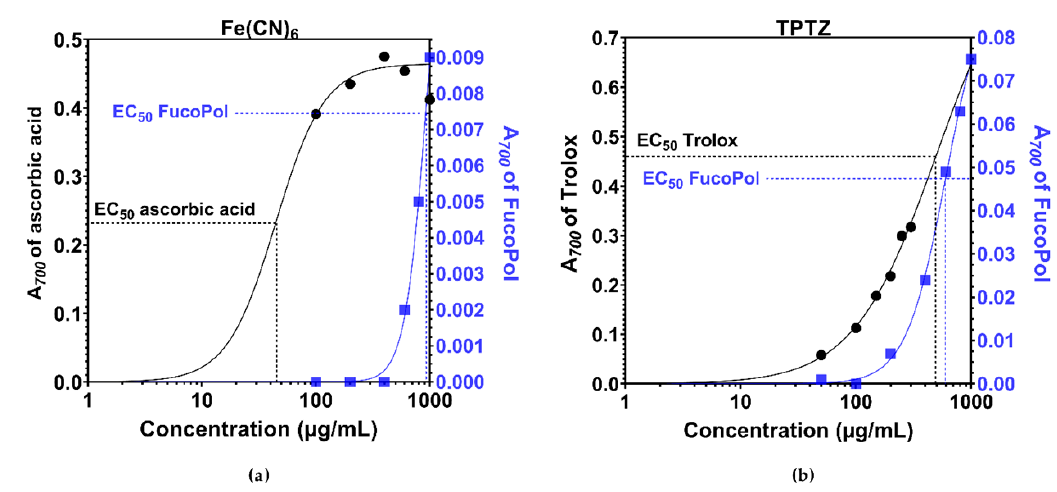
Figure 2. Model fitting of Hill binding kinetics. EC 50 and Hill slope was determined using Equation (1) for both FRAP assays using ( a ) ferricyanide and ( b ) TPTZ mean absorbance data. Data for FucoPol is represented in blue